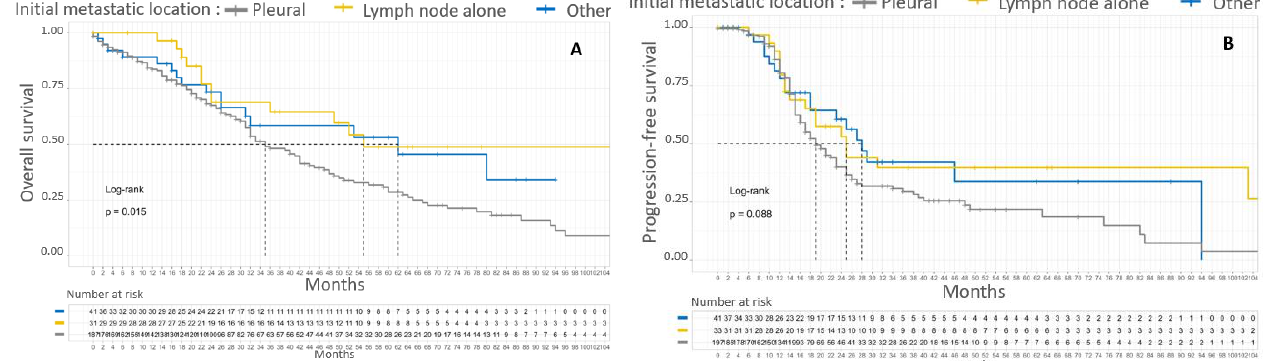
Figure 4. Kaplan–Meier OS ( A ) and PFS ( B ) curves for patients with FIGO stage IV EOC according to